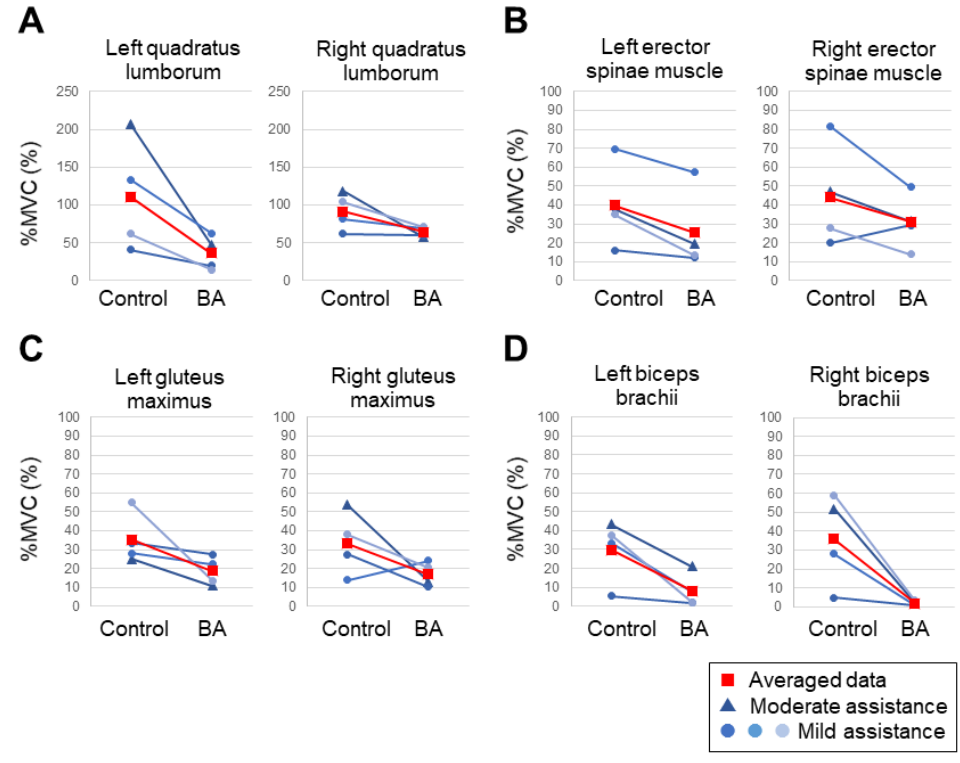
Figure 3. Comparison in muscle activity of left and right quadratus lumborum ( A ), erector spinae ( B ), gluteus maximus ( C ), and biceps brachii ( D ) when assisting a patient out of the bathtub without or with BA. The symbols (triangles and circles) filled in blueish colors in each graph represented EMG data obtained from the caregivers caring for patients with moderate (ID1) and mild assistance (ID2–ID4), respectively. The red square represented the averaged EMG data in each muscle.